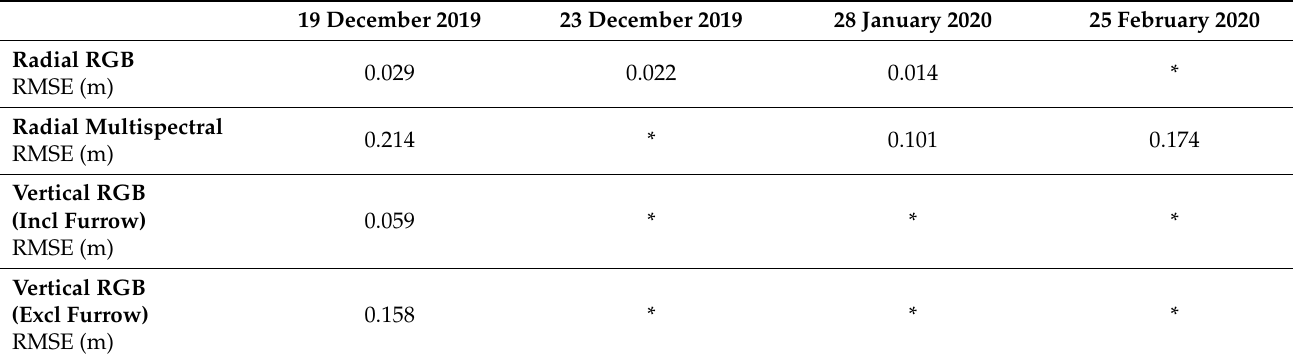
Table 2. Radial and vertical error estimation.